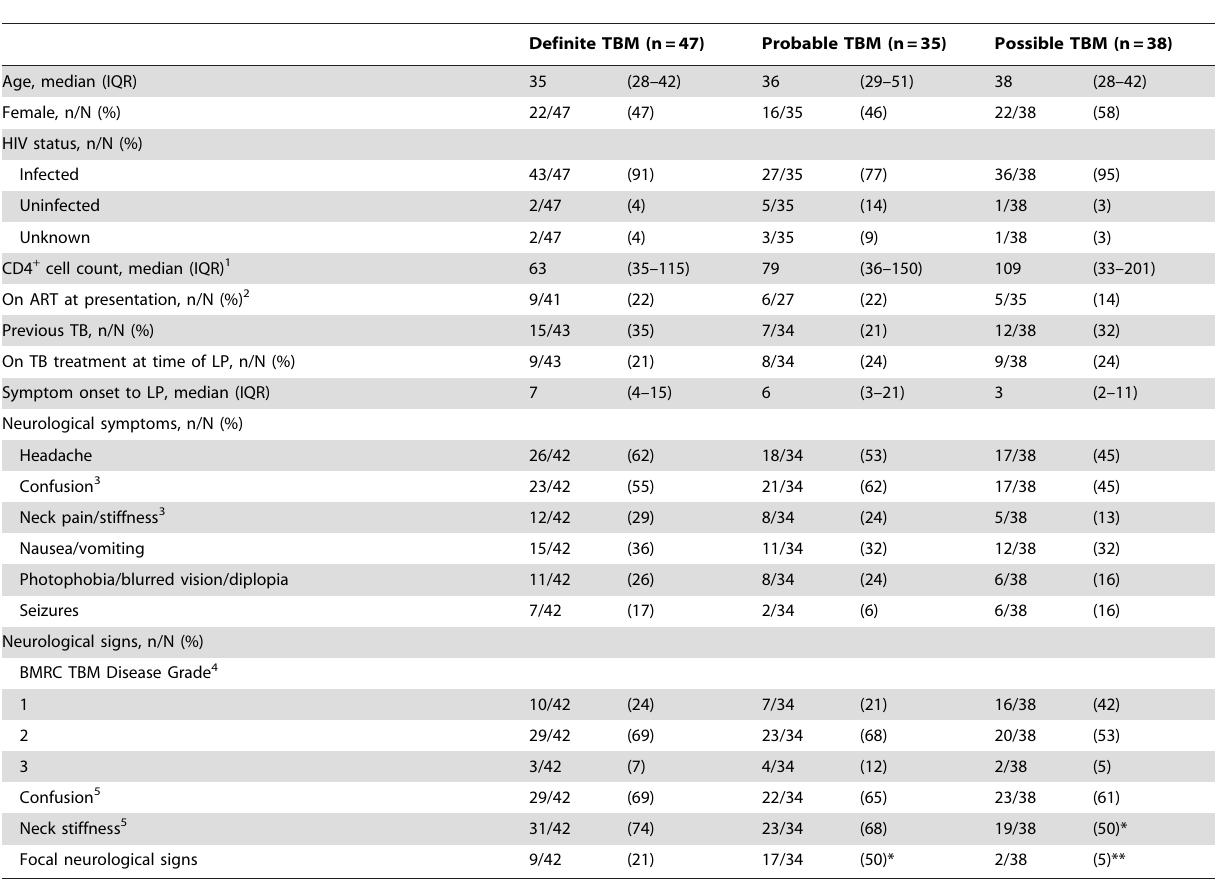
Table 1. Demographic and clinical characteristics of patients with definite, probable and possible tuberculous meningitis (TBM).